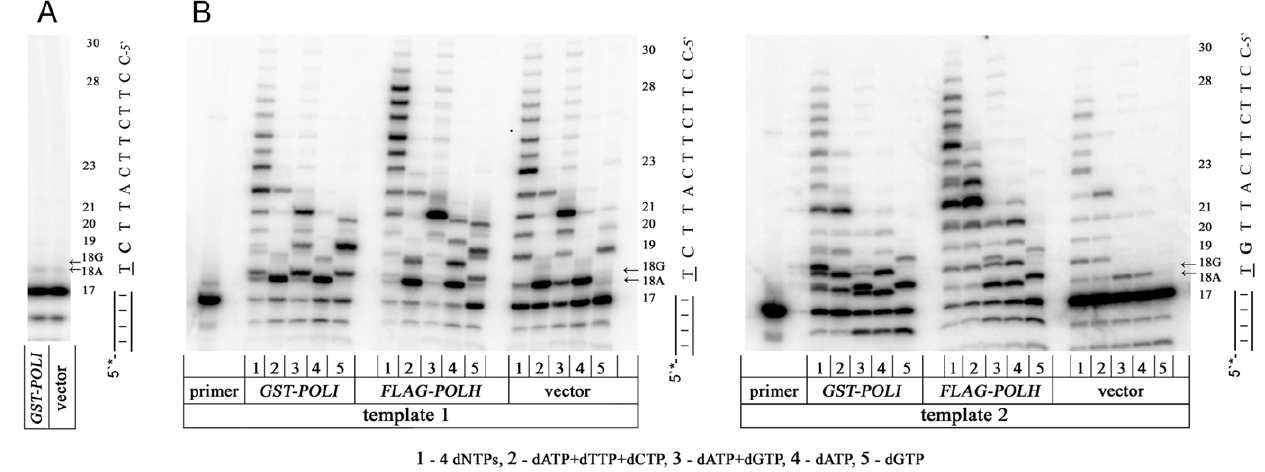
Figure 2. Detection of misGvA activity of Pol i . A. DNA-polymerase activity of yeast extracts producing Pol i or transformed by empty vector in the absence of dNTPs in reaction mixture. The reactions were carried out at 37 u C for 15 min as described in ‘‘Material and Methods’’ using standard template 1 [4;31], with no dNTPs in the reaction mixture. DNA oligonucleotides were separated on 18% polyacrylamide/7 M urea gels and visualized using Storage Phosphor Screen in Typhoon 9700. B. misGvA activity by yeast extracts producing human Pol i , Pol g or transformed with empty vector. Template 1 (left panel, standard substrate) and template 2 (modified substrate with the substitution of C to G at the position of 19) were incubated with yeast cell extracts and high concentrations of exogenous nucleotides. The activity of Pol i produced in yeast is detectable by the misincorporation of dGTP opposite template T by whole cell extracts (‘‘misincorporation of G’’ method of Gening, abbreviated as misGvA). The cells extracts of yeast producing Pol i , Pol g or containing empty vector were used as an enzymatic preparation for DNA polymerase reaction with P 32 - labeled oligonucleotide substrate in the presence of 0.15 mM Mn 2 + divalent metal ions and various combinations of equal concentrations of 1 mM dNTPs. For each extract, five different conditions have been used: 1) all dNTPs, 2) dATP, dTTP and dCTP but with dGTP omitted, 3) dGTP and dATP, 4) only dATP, and 5) only dGTP. Template 2 with the substitution of the next nucleotide upstream ( + 2, corresponding to the position of 19 on elongated primer) after the T template ( + 1, position of 18) from C to G was used to exclude the possibility of transient misincorporation by the template slippage mechanism. The reactions were carried out at 37 u C for 15 min. DNA products were separated on 18% polyacrylamide/7 M urea gels and visualized using Storage Phosphor Screen in Typhoon 9700. The Pol i activity was determined by the presence of the two ‘‘doublet’’ radioactive bands corresponding to 18-mer oligonucleotides with A or G at the 3 9 -end, possessing different electrophoretic mobility. The lower band with higher mobility is indicative of the amount of oligonucleotide with 3 9 -terminal A, whereas the upper band corresponds to the amount of a less mobile oligonucleotide with G incorporated opposite T in position 18 (lines 1 and 3).